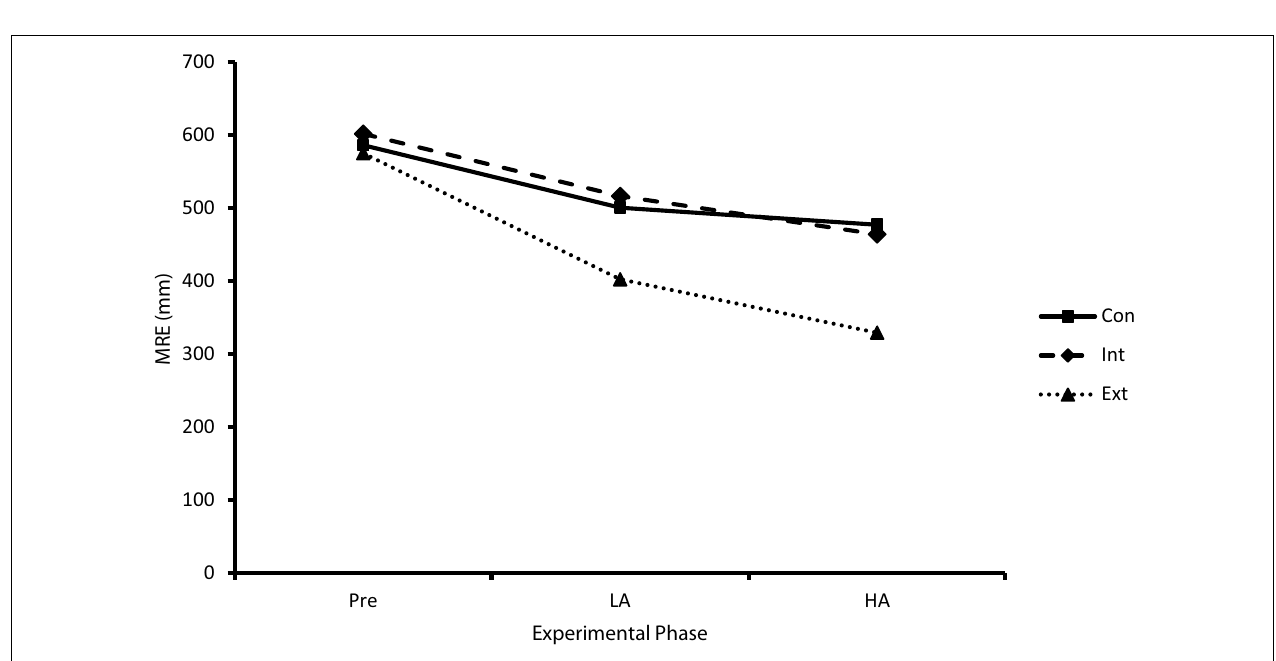
FIGURE 3 | Performance (MRE) as a function of attentional focus (Con, control; Int, internal; Ext, external) and experimental phase (Pre, pre-test; LA, low anxiety; HA, high anxiety).